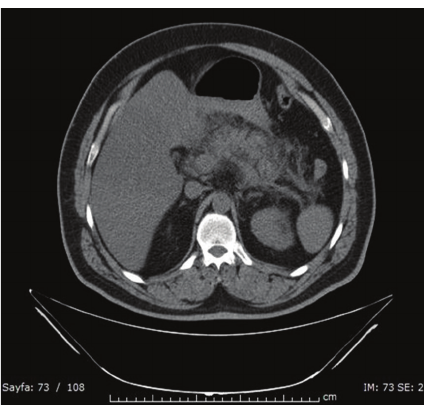
Figure 1: Computed tomography of abdomen showed edematous characteristics in peripancreatic region.